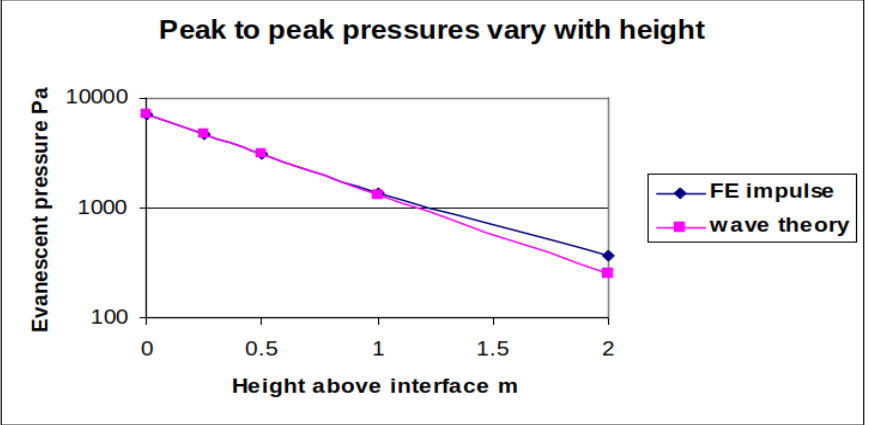
Figure 13. The pressure amplitudes (peak to peak) plotted on a log scale against